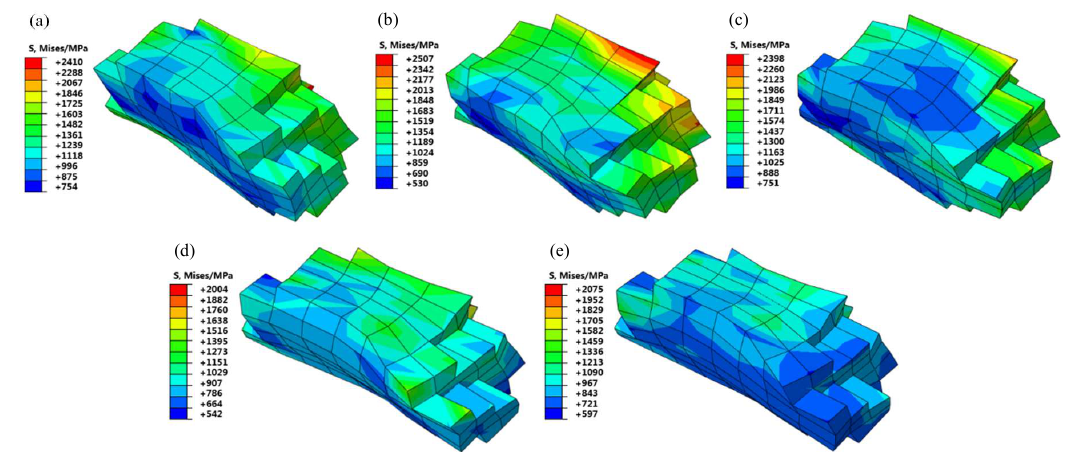
Figure 8. Grain morphology and Mises stress distribution after the G411 deformation: ( a ) Brass; ( b ) Copper; ( c ) S; ( d ) Cube; ( e ) Goss.